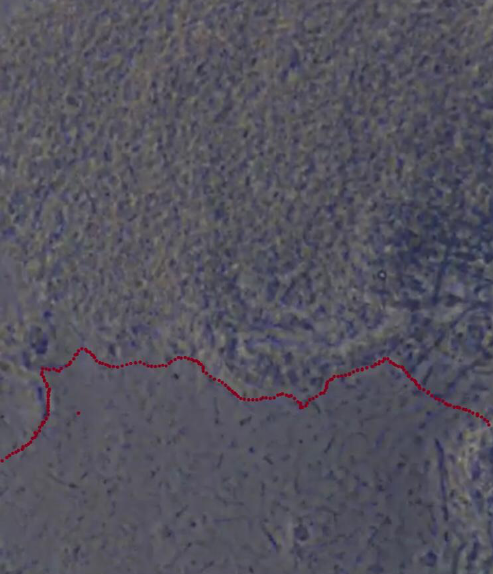
Figure 7. Contrast phase microscope with dividing line between compatible bacterial flora (above) and non-compatible bacterial flora (below).